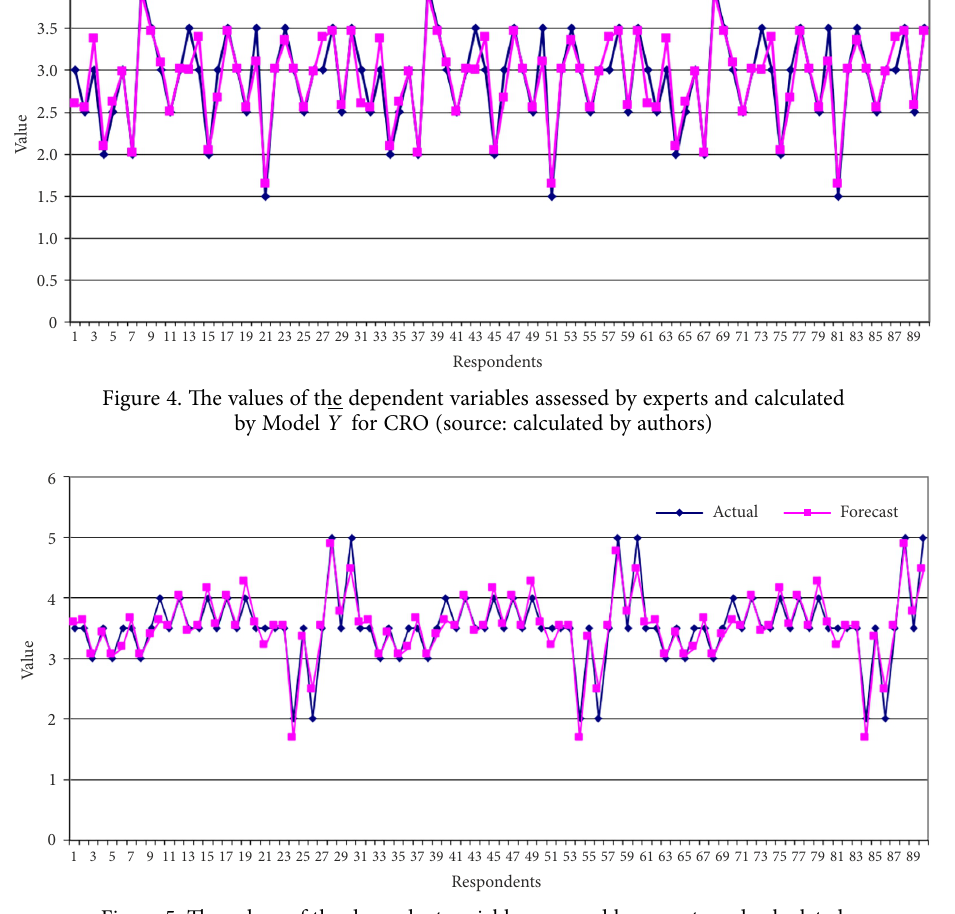
Figure 5. The values of the dependent variables assessed by experts and calculated by Model Y for SLO (source: calculated by Table 3. Mean values of the independent variables and their impact to the dependant variable (source: calculated by authors) Rank